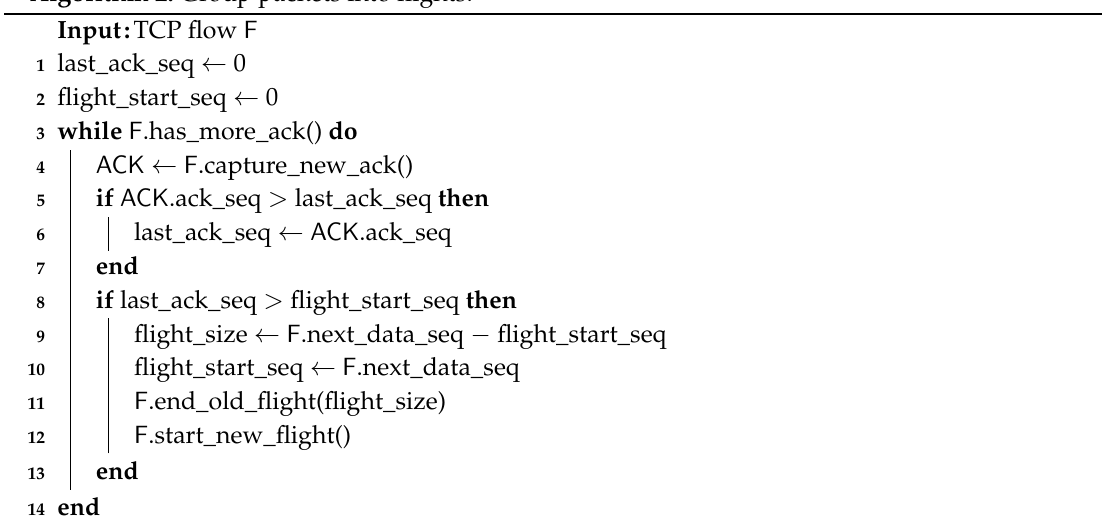
Algorithm 2: Group packets into